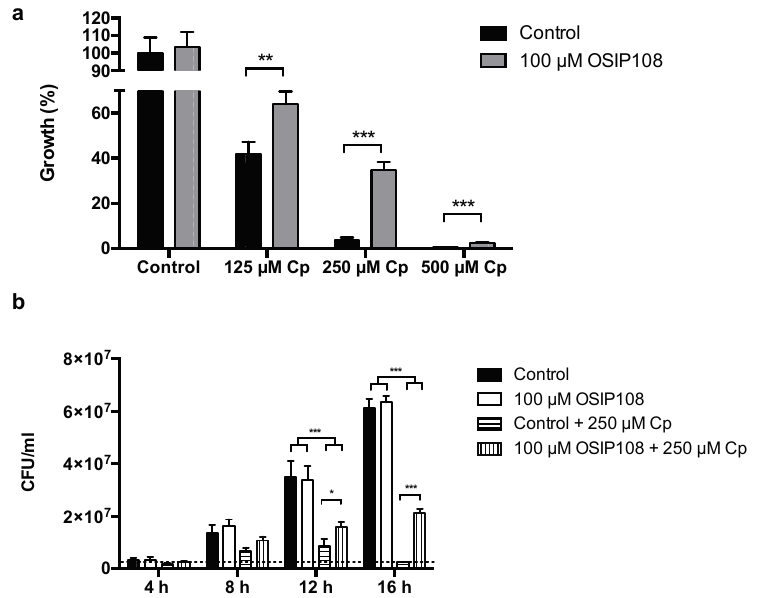
Figure 4. OSIP108 increases yeast tolerance to Cp. ( a ) WT yeast cells were incubated with Cp (125 µM–500 µM) for 16 h in presence of control treatment (2.5% DMSO, black bars) or 100 µM OSIP108 (grey bars). Growth was calculated by determining CFU/mL as compared to control treatment (100%). Experiment performed in quadruplicate, biological repeats is three ( ** p < 0.01; *** p < 0.001; Student t -test) ( b ) WT yeast cells were treated with control (2.5% DMSO; black bars and horizontal dashed bars) or 100 µM OSIP108 (white bars and vertical dashed bars) in absence (black and white bars) or presence (horizontal and vertical dashed bars) of 250 µM Cp. CFU/mL were determined periodically during 16 h of treatment. Dashed line indicates the average CFU/mL at the time point that the experiments were initiated. Biological repeats is three. ( * p < 0.05; *** p < 0.001; ANOVA test using Tukey